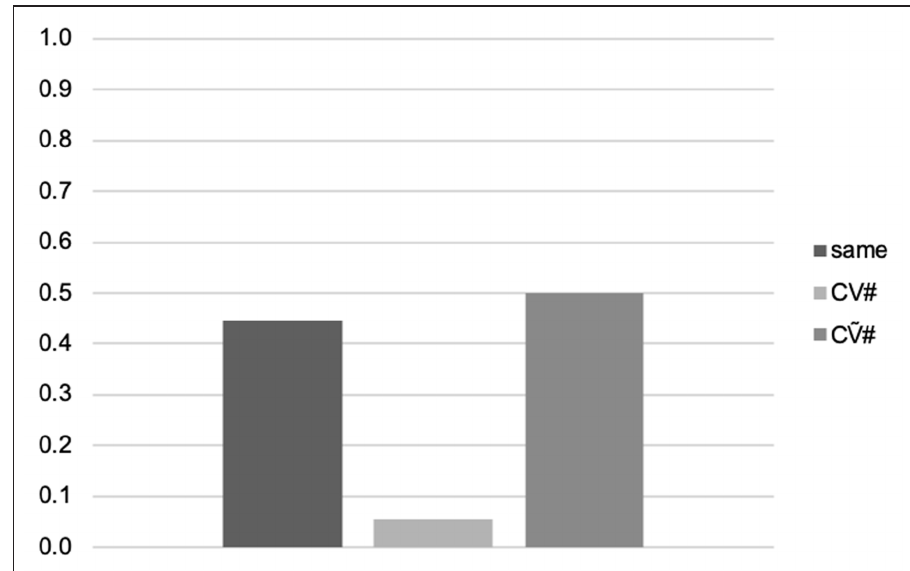
Figure 6: Rating responses for stimulus pairs type